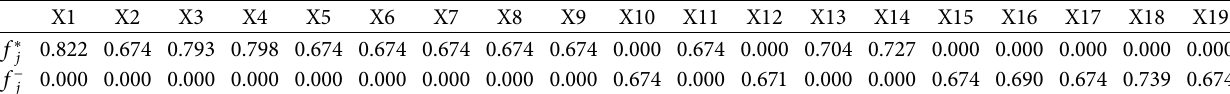
Table 11: Te best value and worst value of each infuence variables.